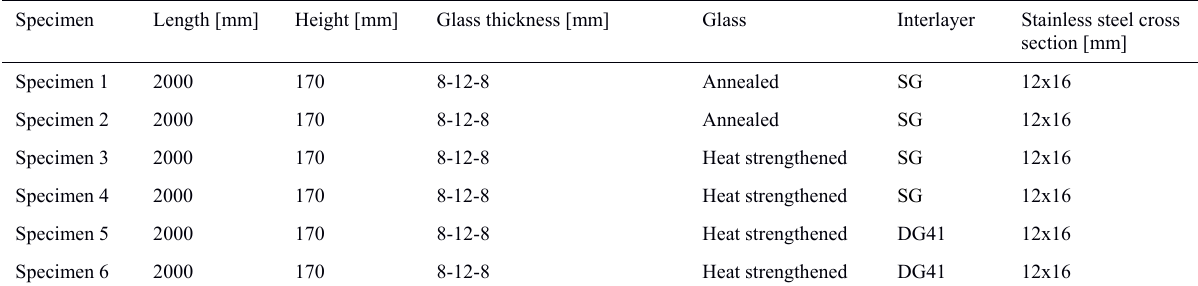
Table 7: Steel-reinforced glass beams experimentally